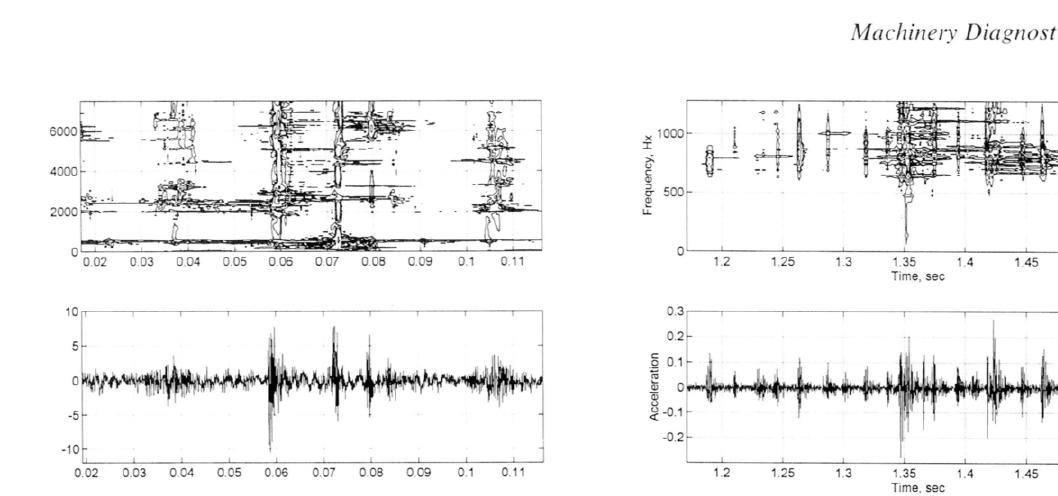
FIGURE 7 Lower plot: acceleration-time history from the intake valve cap on a reciprocating compres sor. Upper contour plot: corresponding Choi-Wil liams distribution.